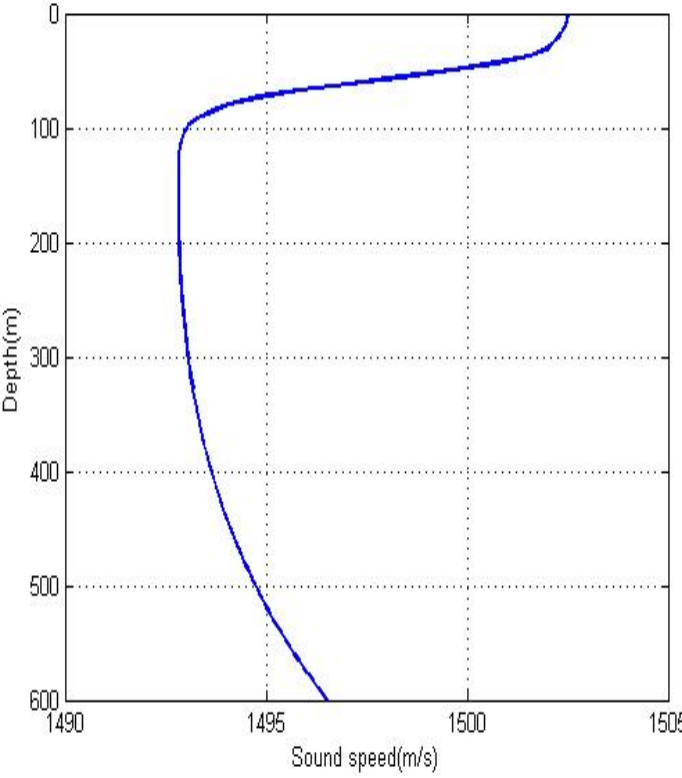
Figure 11. The sound speed profile.